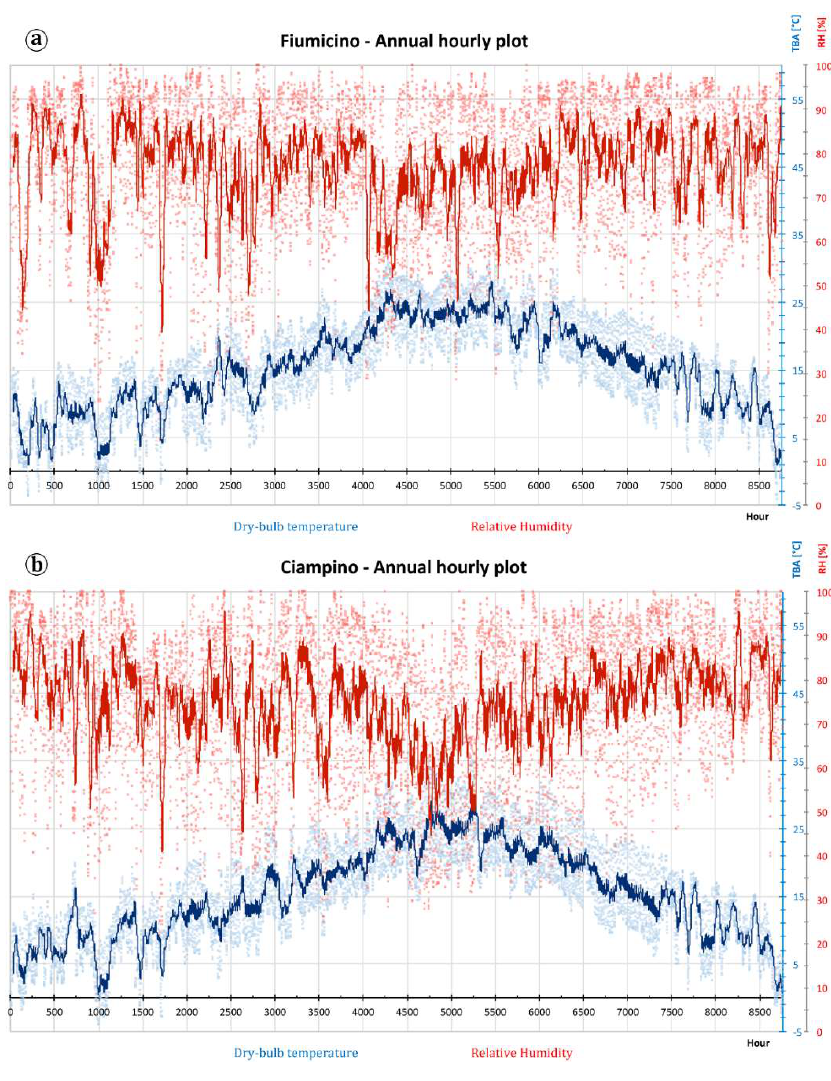
Figure 3. Annual time series of hourly dry-bulb temperature (TBA (°C)) and hourly relative humidity (Ur (%)). Mean (solid lines) and hourly (dotted lines) values are shown. Data were sourced from climate files provided by the EnergyPlus database for Rome, and correspond to the airports of ( a ) Fiumicino, and ( b ) Ciampino.